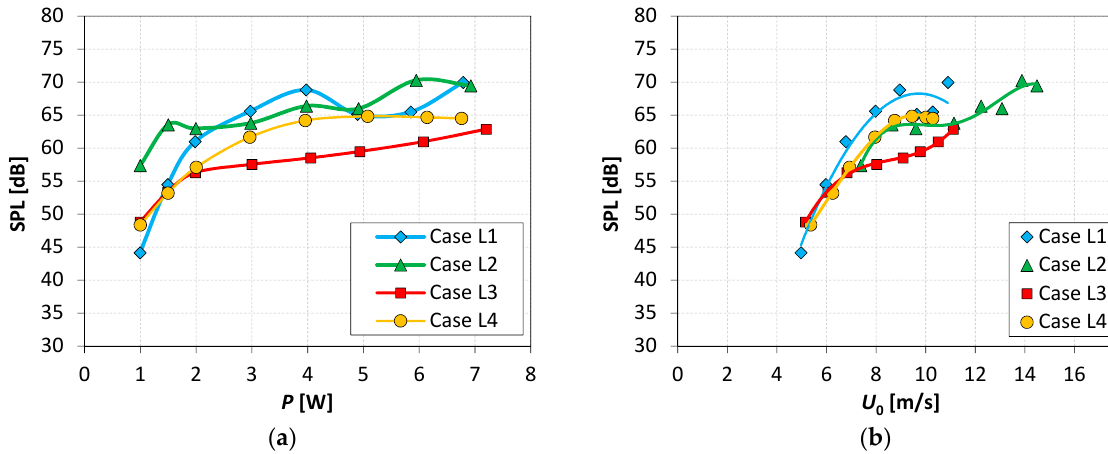
Figure 9. Sound pressure level of the actuators under resonance frequency condition in function of: ( a ) apparent power; ( b ) centerline momentum velocity.